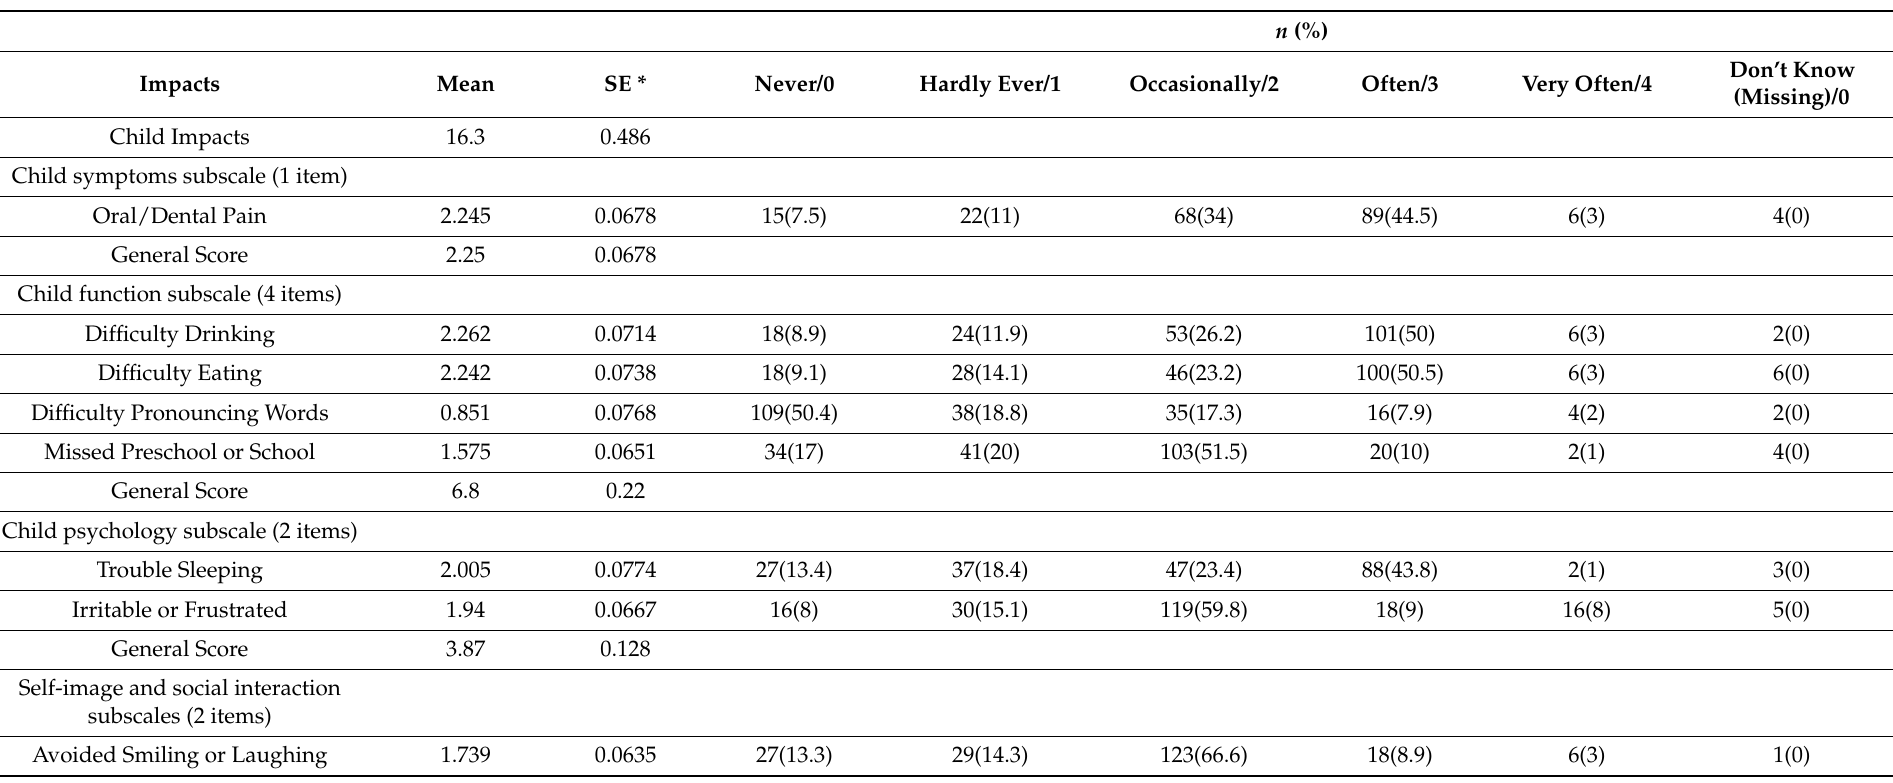
Table 5. Descriptive statistics and summary of Early Childhood Oral Health Impact Scale Responses (ECOHIS) ( n =